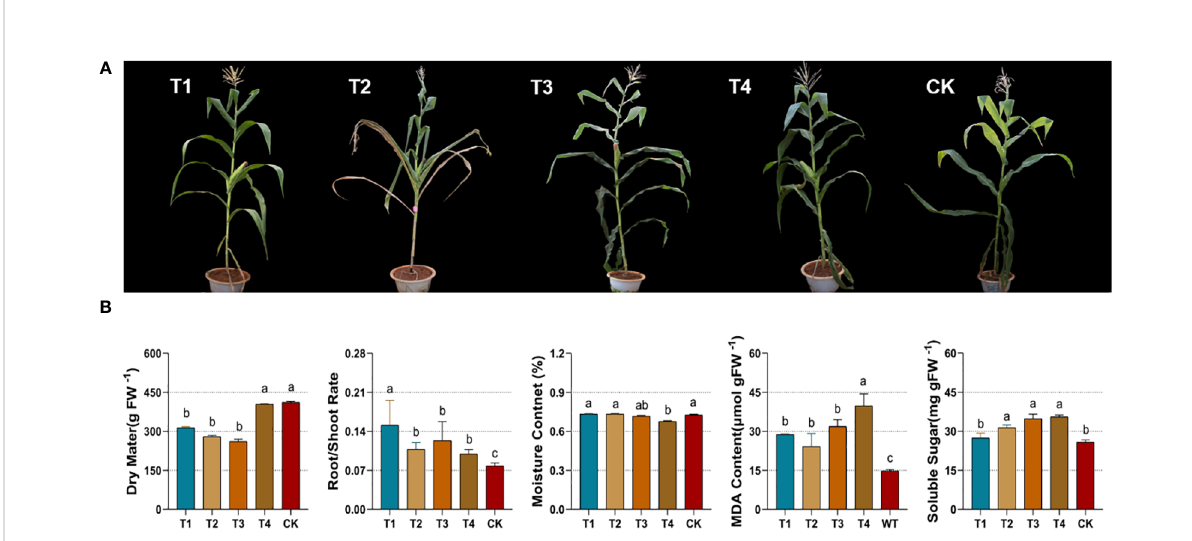
FIGURE 2 Phenotypes (A) and physiological parameters (B) of silage maize under different periods of drought treatments. Figure 1B represents from left to right, the changes in dry matter, root-shoot ratio, moisture content, malondialdehyde and soluble sugars. CK, control group; T1, seedling stage; T2, elongation stage; T3, fl owering stage; T4, maturity stage. Different letters above the bars indicate that the values differ signi fi cantly